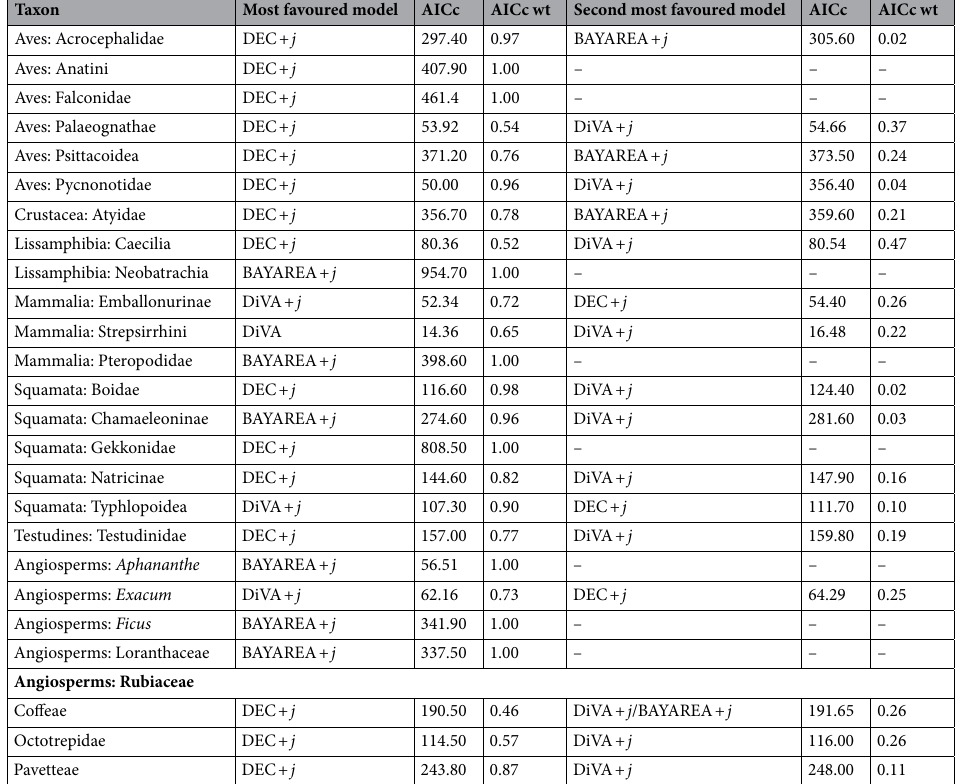
Table 2. Summary of the BioGeoBEARS model test results per taxon/dataset as well as AICc/AICc weights for each model